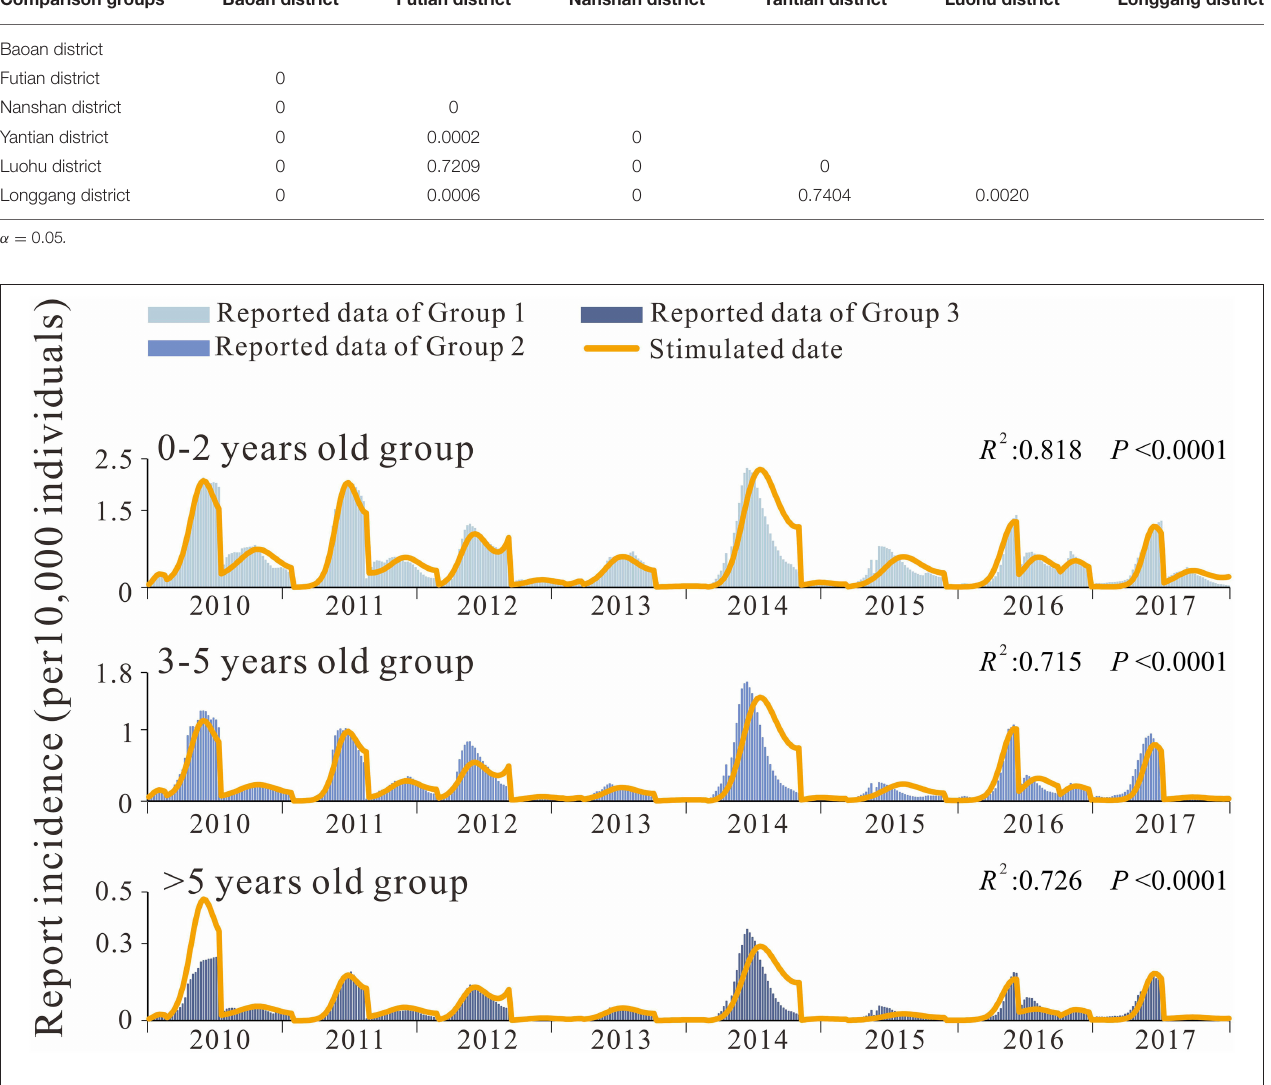
FIGURE 5 | Fitting results for EV71 incidence rates by age